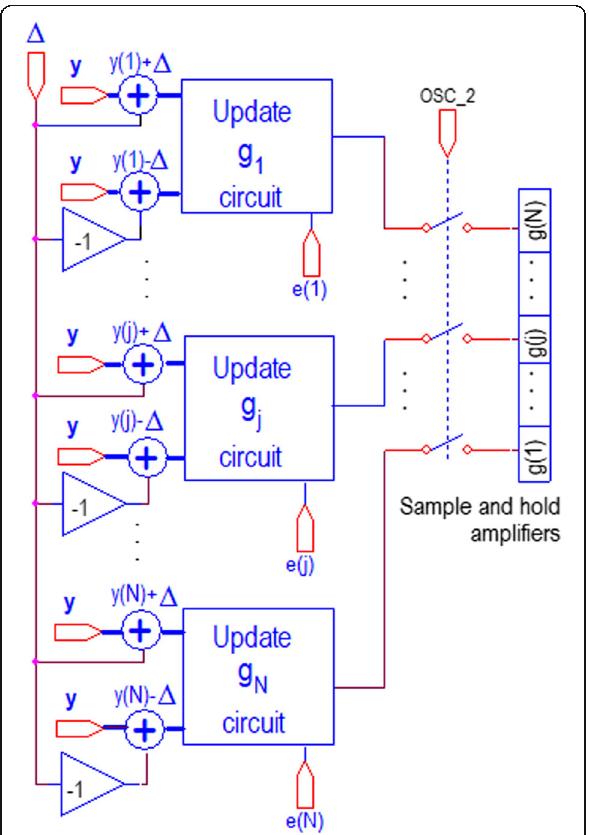
Fig. 4 Block 1: sample and hold circuits controlled by OSC_ 1, START , and Correc signals used to update y p array